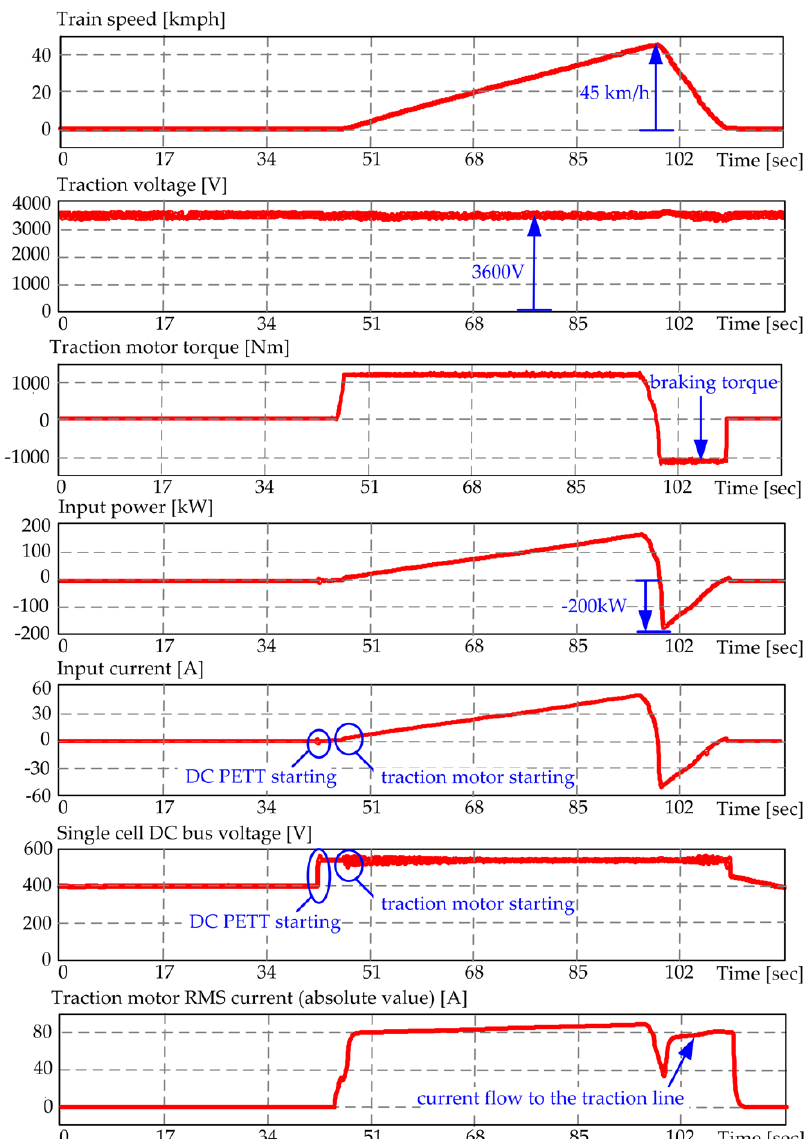
Figure 20. Track test results: Recorded waveforms during start-up of the train with the DC PETT based asynchronous traction drive to a speed of 45 km/h and immediate braking. Top to bottom: (1) train speed; (2) traction motor torque; (3) DC PETT input power; (4) DC PETT input current; (5) traction DC voltage; (6) primary DC bus voltage of a single 4QC-DAB-DC/AC power electronic cell.